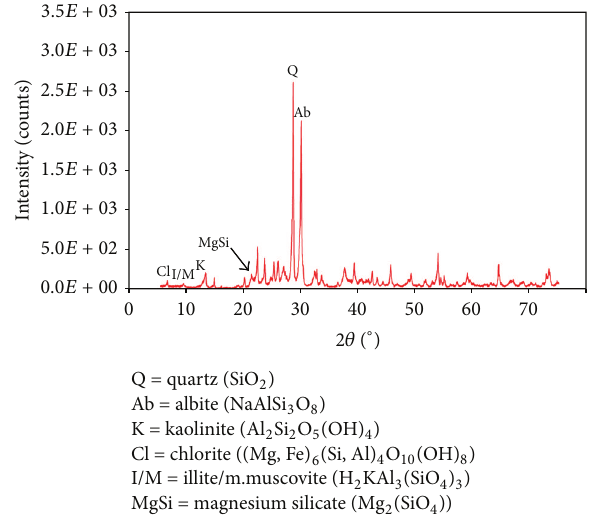
Figure 5: X-ray diffraction pattern for spray-dried